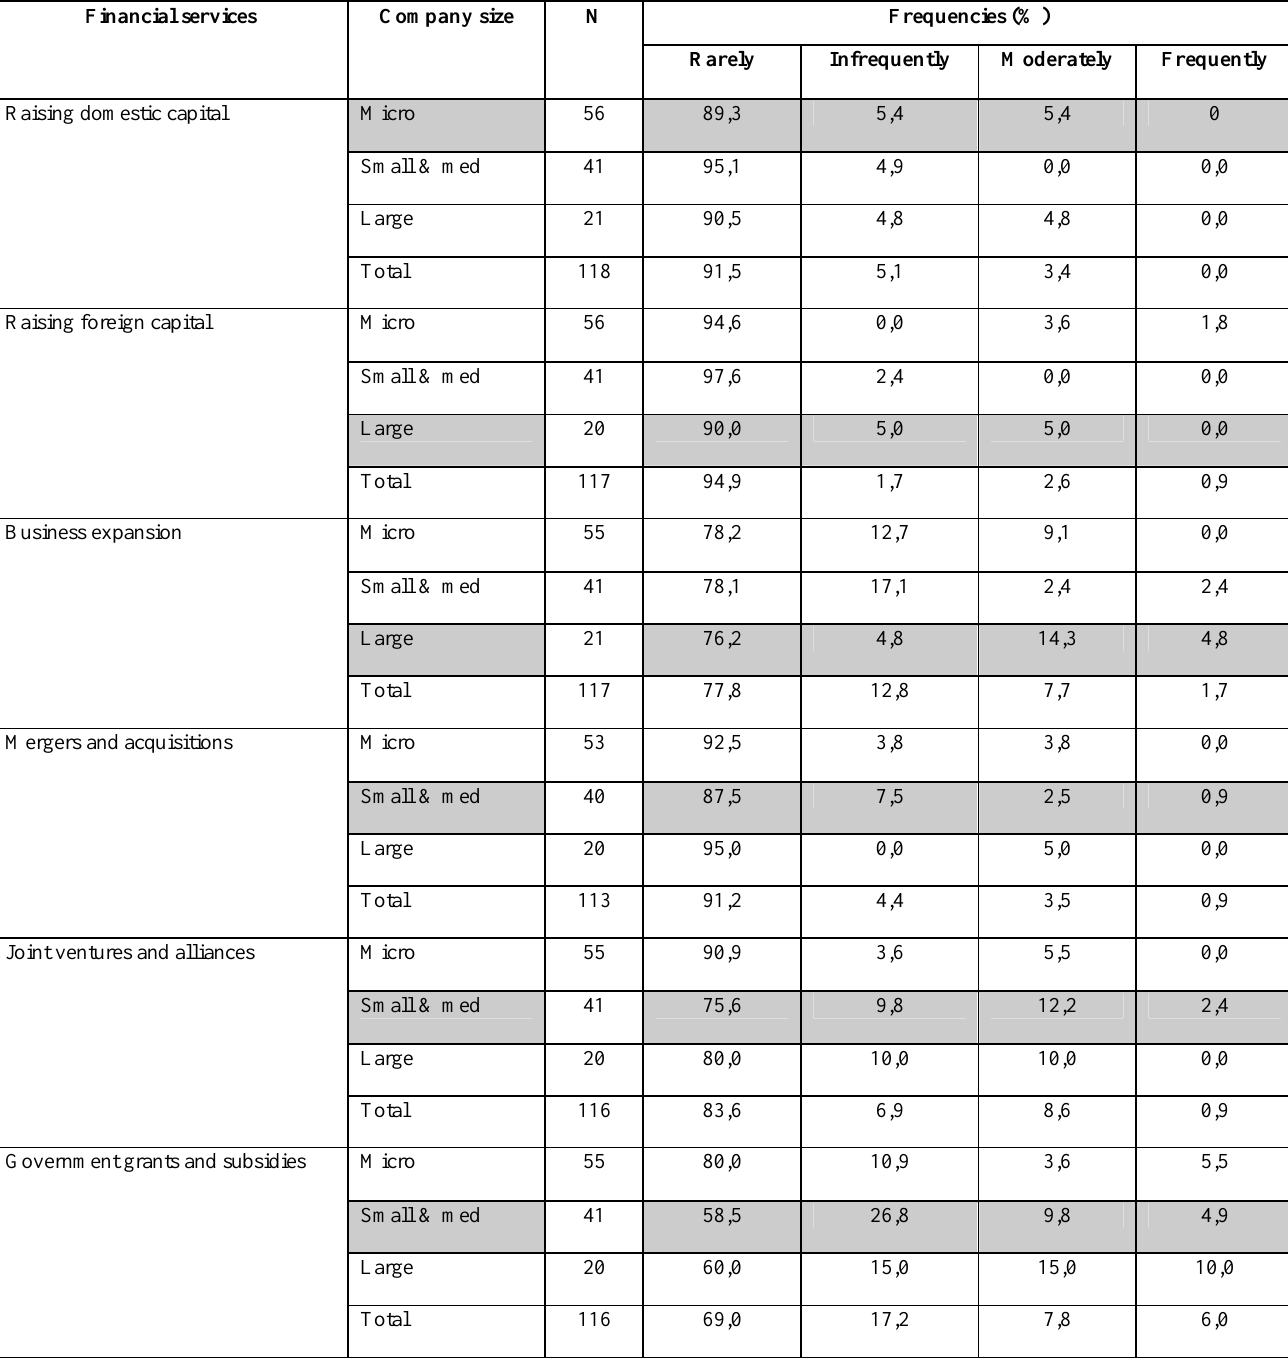
Table 3: Comparison between company size and responses to financial